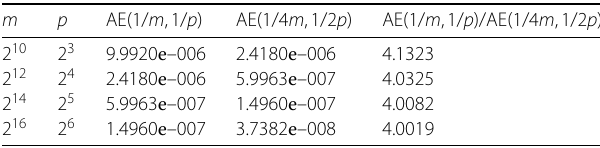
Table 1 Errors of (31) with θ =